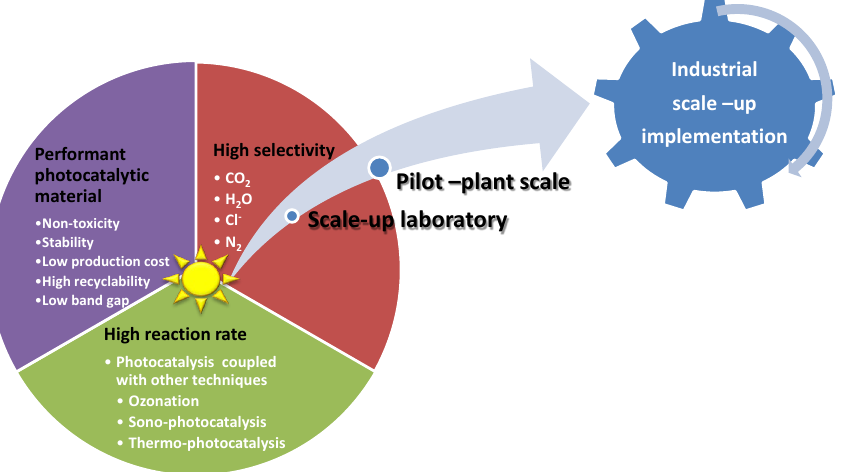
Figure 18. Schematic representation of the challenges and photocatalytic approaches in depollu- tion